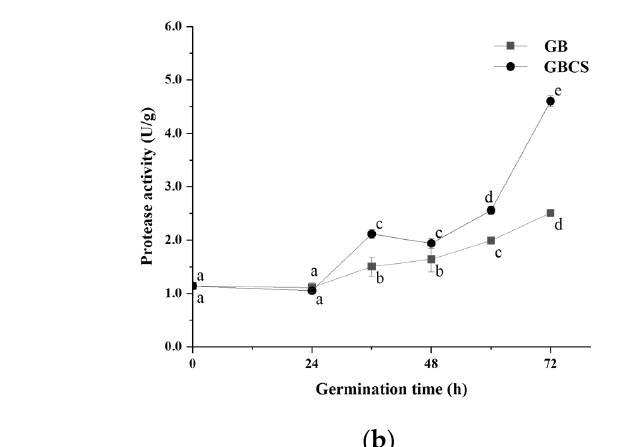
Figure 7. Change in protein content in fl uenced by cold stress and germination. GB, germinated black rice without cold stress; GBCS, germinated black rice under cold stress at 0 °C for 1 h; ( a ) represents the change in protein content in fl uenced by cold stress time; ( b ) represents the change in protein content in fl uenced by germination time with or without cold stress. Means with di ff erent small le tt er superscripts are signi fi cantly di ff erent at p < 0.05.